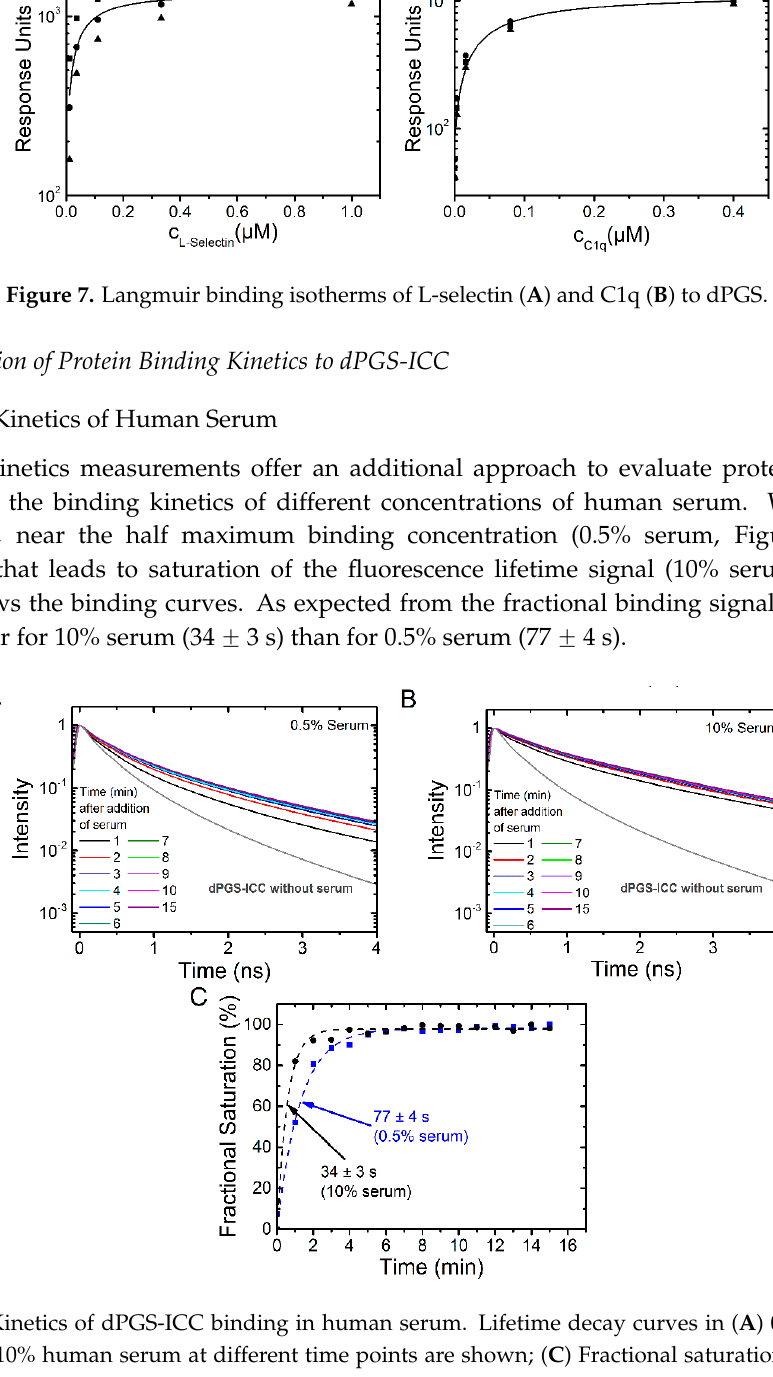
Figure 8. Kinetics of dPGS-ICC binding in human serum. Lifetime decay curves in ( A ) 0.5% serum and ( B ) in 10% human serum at different time points are shown; ( C ) Fractional saturation, based on the mean fluorescence lifetimes, as a function of time. The dashed lines indicate an exponential fit to the data and the time constant τ was 34 s for 10% serum and 77 s for 0.5% serum.